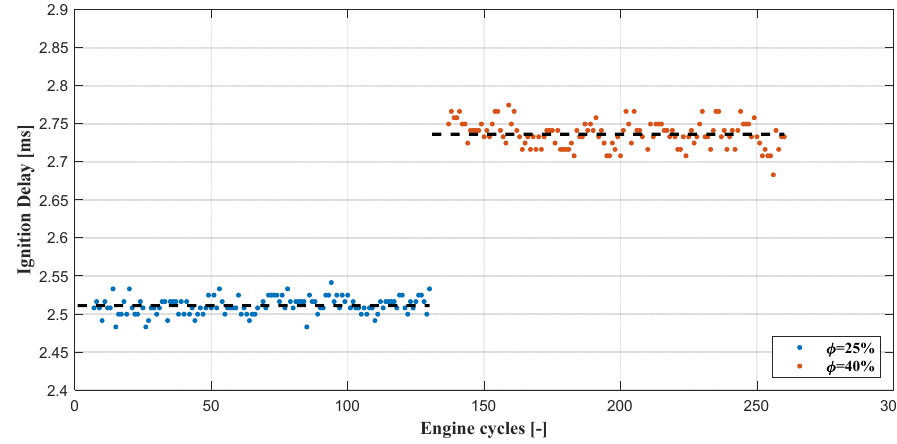
Figure 13. Effect of different relative humidity on ID.